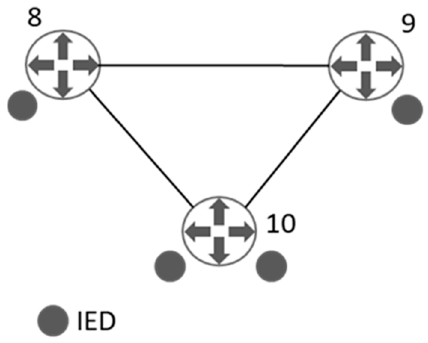
Figure 3. A three-buses communication network.